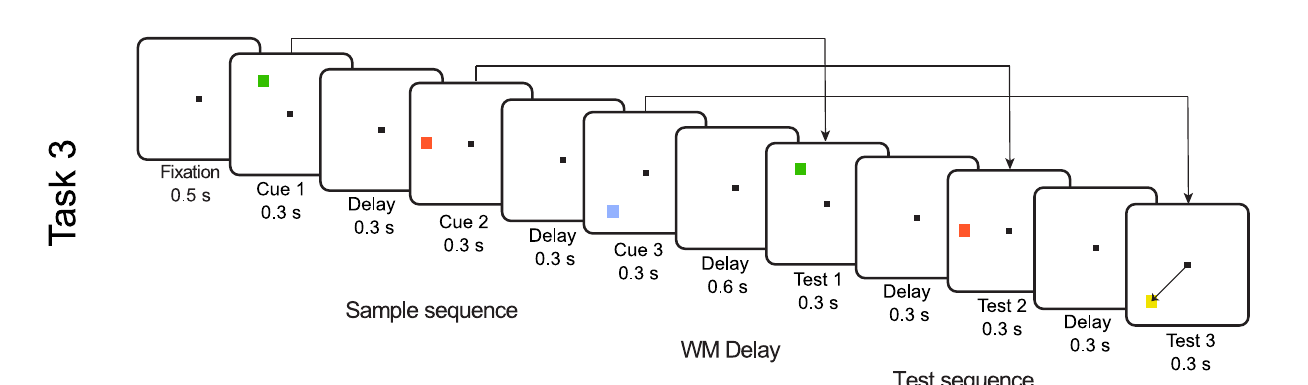
Fig. 3 | Task 3. In Task 3, two or three colored squares were presented in a sequence. Their location and color were to be remembered. Following the 0.6s